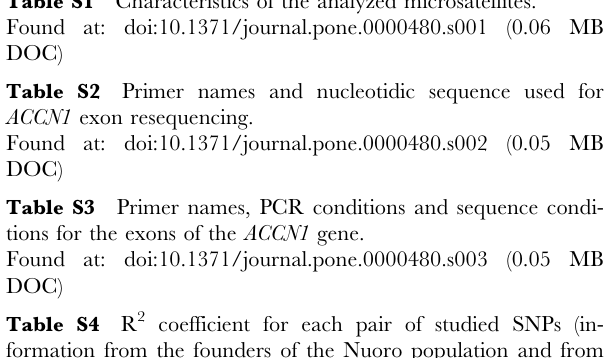
Table S1 Characteristics of the analyzed microsatellites.